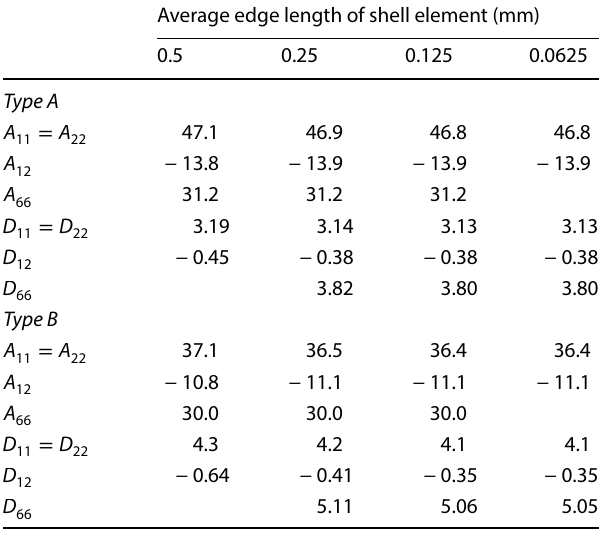
Table 1 Characterized elastic components of the ABD-matrix for the Type A and B RVEs. Three levels of mesh refinement are pre- sented for each constant to illustrate convergence for each compo- nent of the ABD-matrix. A ij is given in MN/m whereas D ij is given